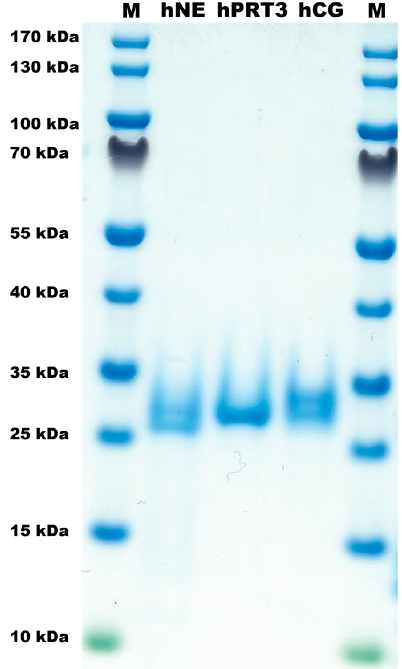
Figure 1. Analysis of the purified hNE, hPR-3, and hCG used in the analysis of their cleavage activity of the large panel of human cytokines and chemokines. The three human neutrophil enzymes were commercial preparations purified from peripheral blood neutrophils. The enzymes were analyzed by separation on SDS-PAGE and visualized with Coomassie Brilliant Blue